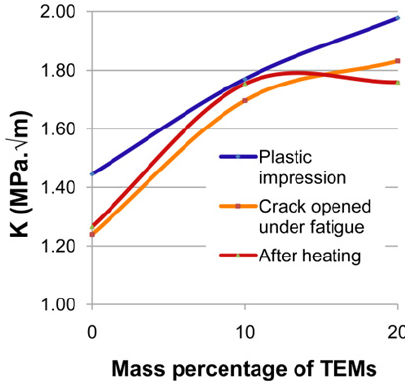
Figure 8: Fracture toughness as a function of TEMs mass fraction for adhesive AV138.